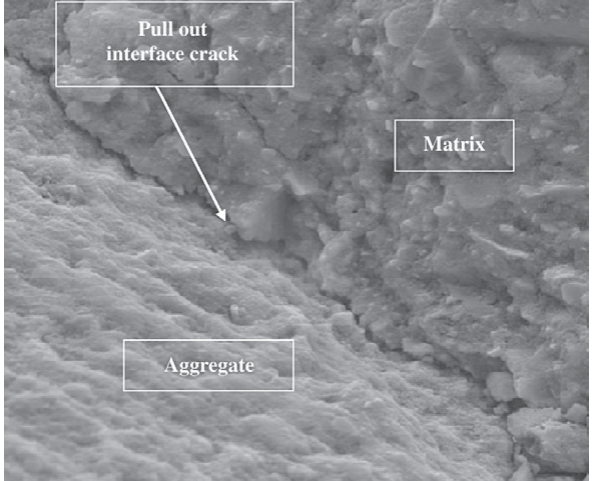
Figure 5. Fracture surface of unfired specimens AR1, AR2, AR3, AR4 and